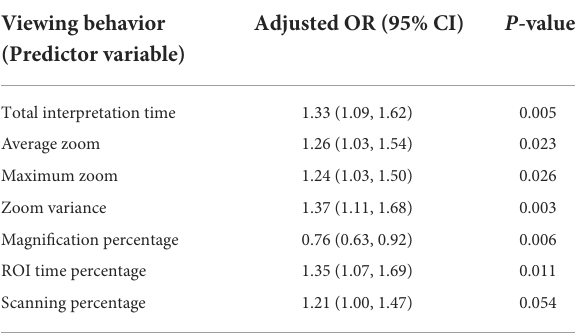
TABLE 5 Pathologists’ viewing behaviors and their association with diagnostic accuracy (This table was published in Journal of Pathology Informatics, Vol 13, F. Ghezloo, P. Wang, K. F. Kerr, T. T. Brunye, T. ´ Drew, O. H. Chang, L. M. Reisch, L. G. Shapiro, J. G. Elmore, “An analysis of pathologists’ viewing processes as they diagnose whole slide digital images,” 1–6, Copyright Elsevier